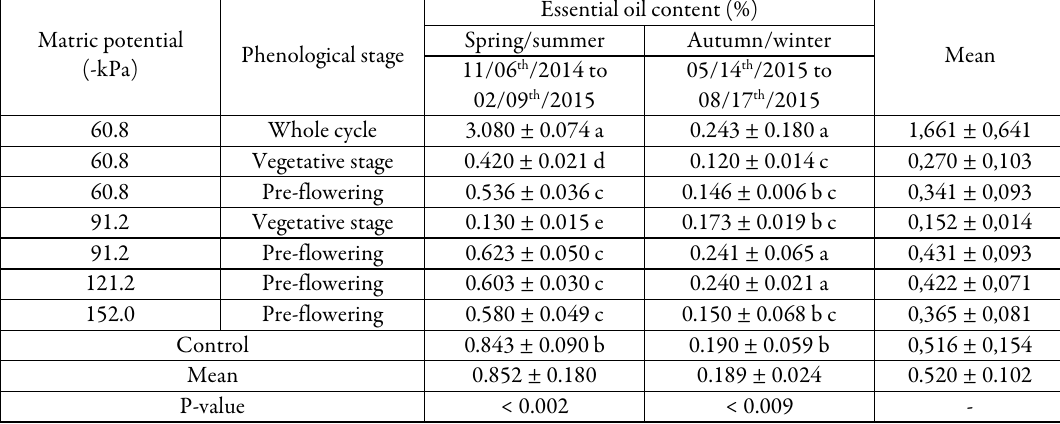
Table 5. Origanum vulgare L. essential oil content within the experiments Matric potential